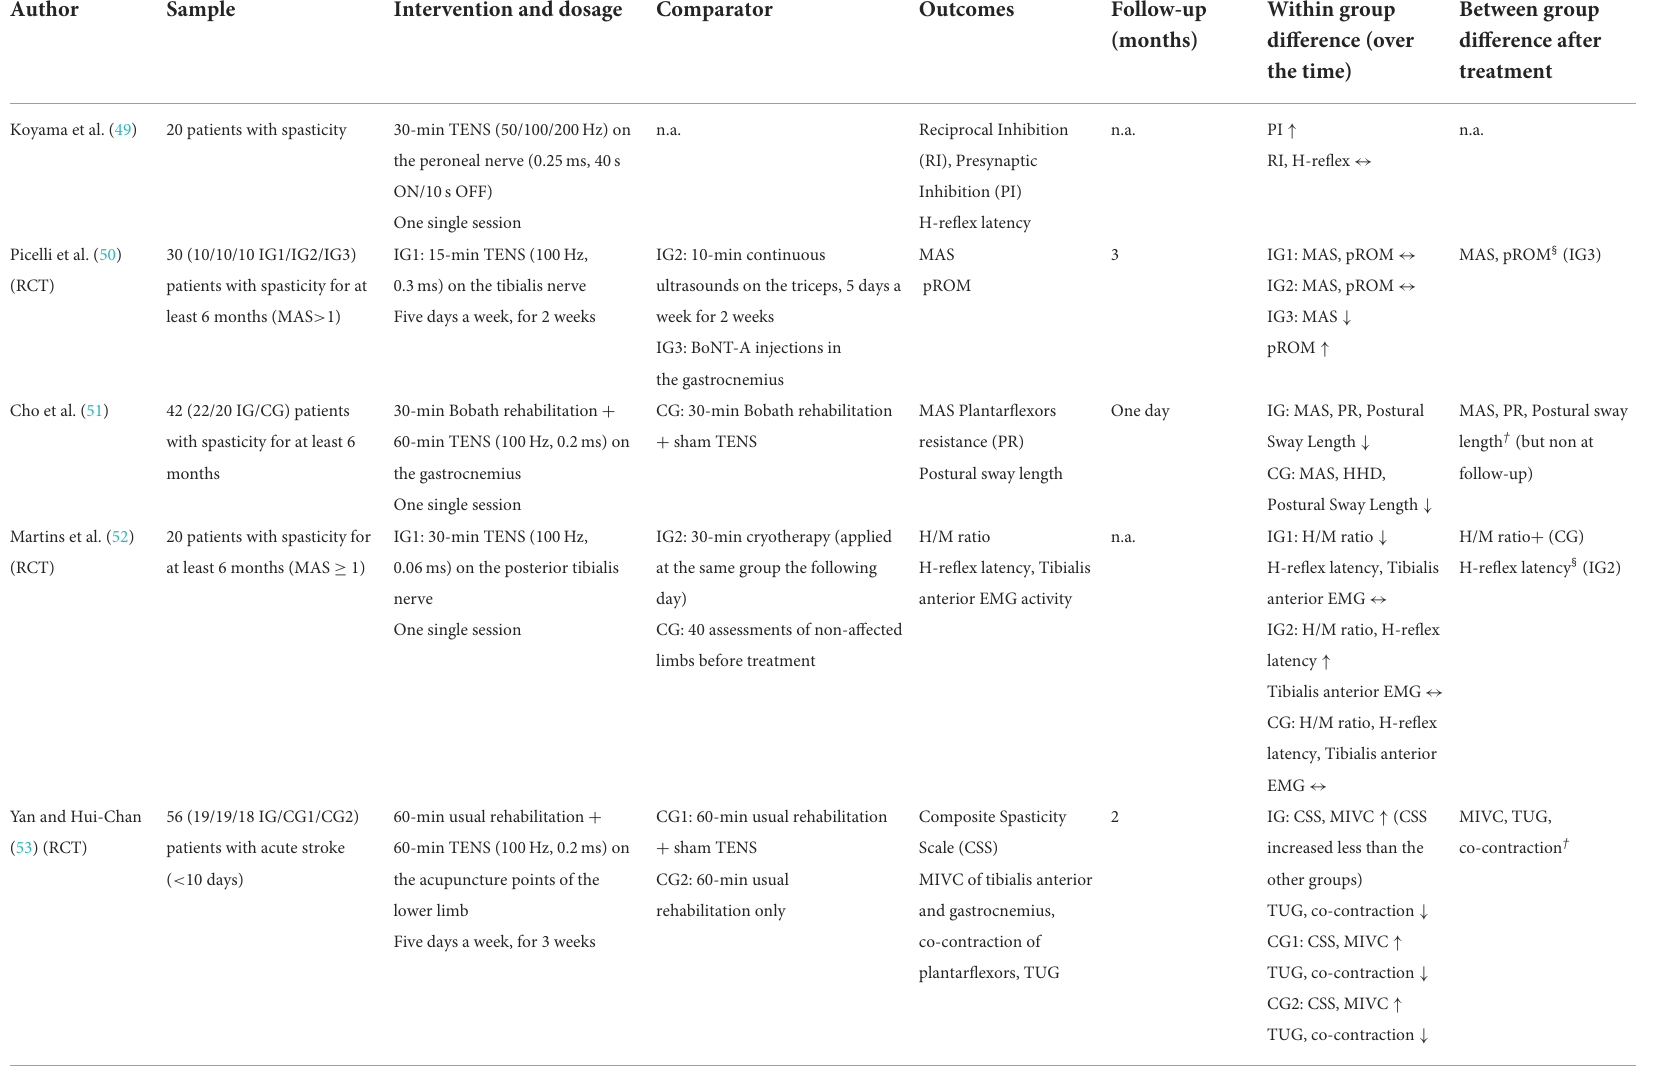
TABLE 5 Characteristics of studies using Transcutaneous Electrical Nerve Stimulation (TENS) for the treatment of triceps spasticity after